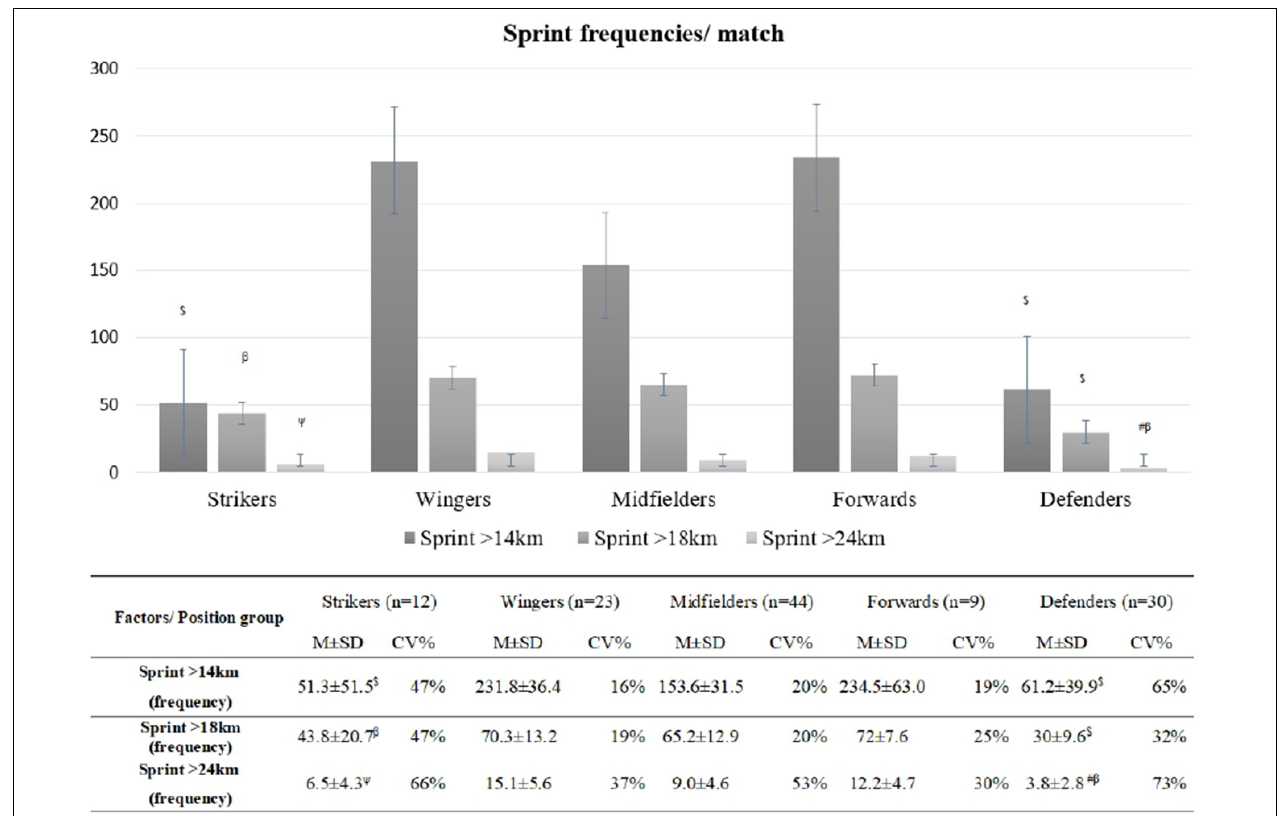
FIGURE 1 | Sprint frequencies by player position. $ Significant differences from all other groups; # significant differences from Defenders; ψ significant differences from Forwards; β significant differences from Wingers, p < 0.05 for all